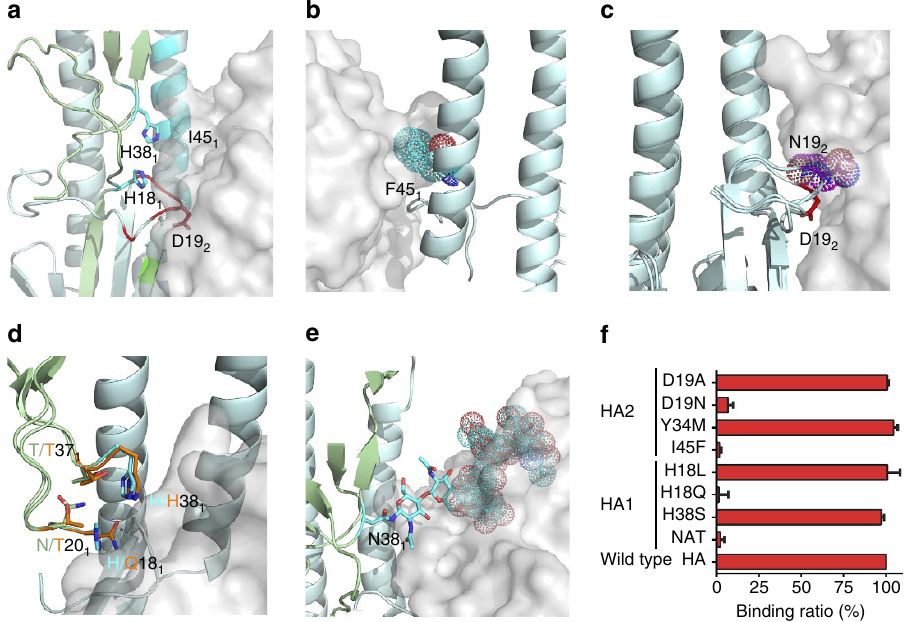
Figure 5 | Residues in the natural variants that may affect 3E1 recognition. ( a ) Locations of the key residues of HA (shown with side chains) that may affect 3E1 recognition. The HA is shown in cartoon and the 3E1 Fab in surface representation. The colour coding of HA is the same as Fig. 3b. ( b ) The I45F variant (shown with side chain and dots) in HAs of the H2 subtype viruses could cause steric hindrance with the HCDR3 loop of 3E1 in the HA of Jap57 (H2) structure (PDB code: 2WRD). ( c ) The D19N variant in HAs of the H13 subtype viruses adopts a different side-chain conformation in the HA of ML77 (H13) structure (coloured in magenta, PDB code: 4KPQ), which could cause steric hindrance with 3E1. ( d ) The H18Q variant in HAs of the H9 subtype viruses makes relatively weaker interactions with Asn20, Thr37 and His38 in the HA of KO98 (H9) structure (coloured in orange, PDB code: 1JSD), which might interfere with the recognition by 3E1. ( e ) The glycans at Asn38 in the HAs of the H3 and H7 subtype viruses might obscure the recognition by 3E1. The glycans at Asn38 in the HA of HK68 (H3) structure (PDB code: 4WE4) are shown as cyan sticks. ( f ) Relative binding ratio of the mutants of WA11 HA with the 3E1 Fab. Bars represent mean ± s.d. Data represent a representative experiment from three independent